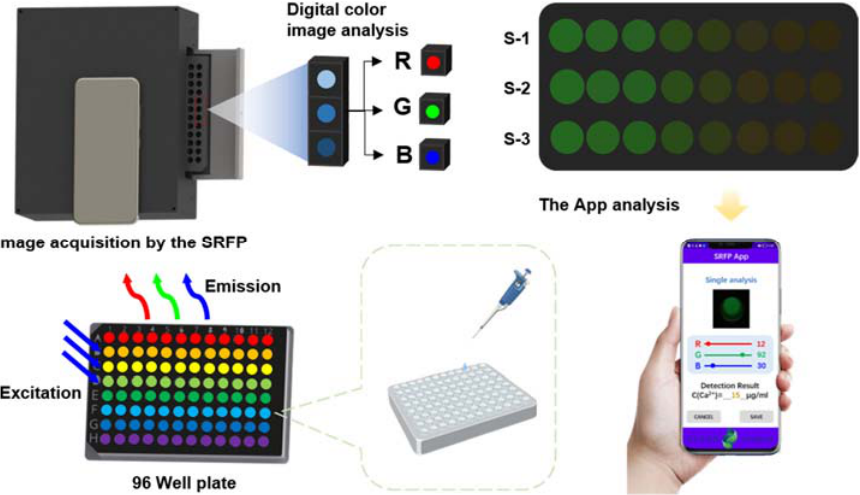
Figure 1. Schematic illustration of SRFP system and its application in bovine blood calcium sensing and concentration detection. A series of Cal Red R525/650 mixed solutions containing different Ca 2+ ions content in bovine serum was put into a 96 ‐ well plate. Fluorescence images of samples at different known concentrations were obtained with the SRFP platform. The prediction of Ca 2+ concentration in unknown bovine serum samples is achieved by converting the corresponding image information into the ratio of red and green channels through the built ‐ in image processing program.